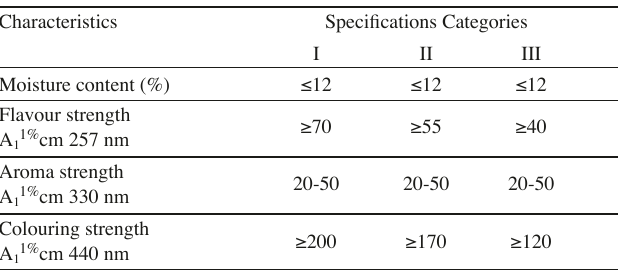
Tab. 1: Quality category limits for saffron in filaments according to ISO 3632 1,2:2010-2011.